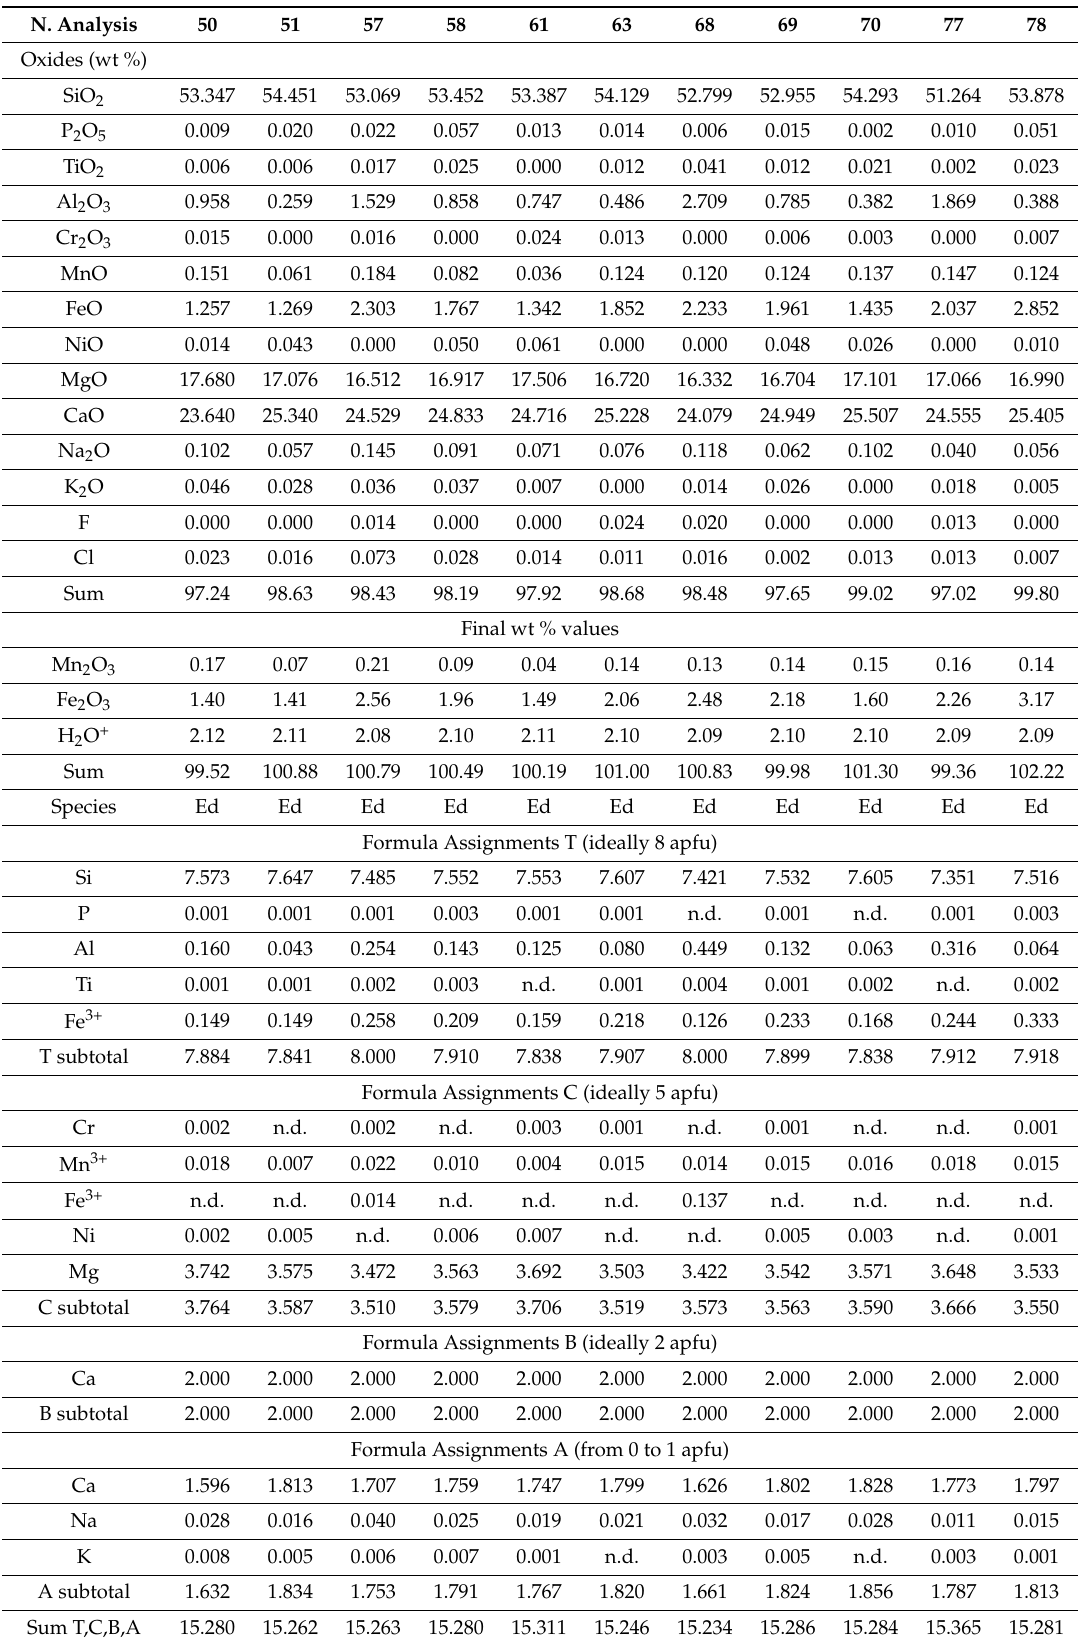
Table 4. Chemistry of selected fibrous edenite crystals in serpentinites samples from the Pollino Massif. N.